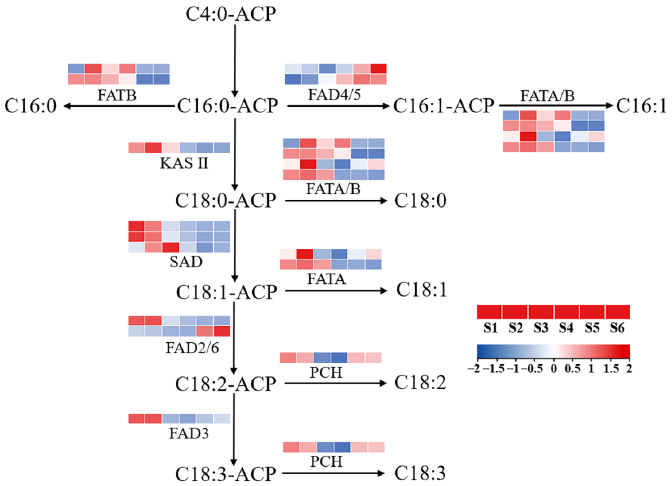
Figure 4. The biosynthesis pathway of major fatty acids in Tartary buckwheat during seed develop- ment. Gene encoding enzyme(s) and metabolites are indicated in black font. Heat maps show the normalized gene expression values (FPKM) from RNA-seq data at six different development stages of seeds. S1, S2, S3, S4, S5, and S6 represent the 10, 13, 16, 20, 25, and 30 days after pollination (DAP), respectively. FPKM value was a mean value of three biological replicates from the same sample RNA-seq.